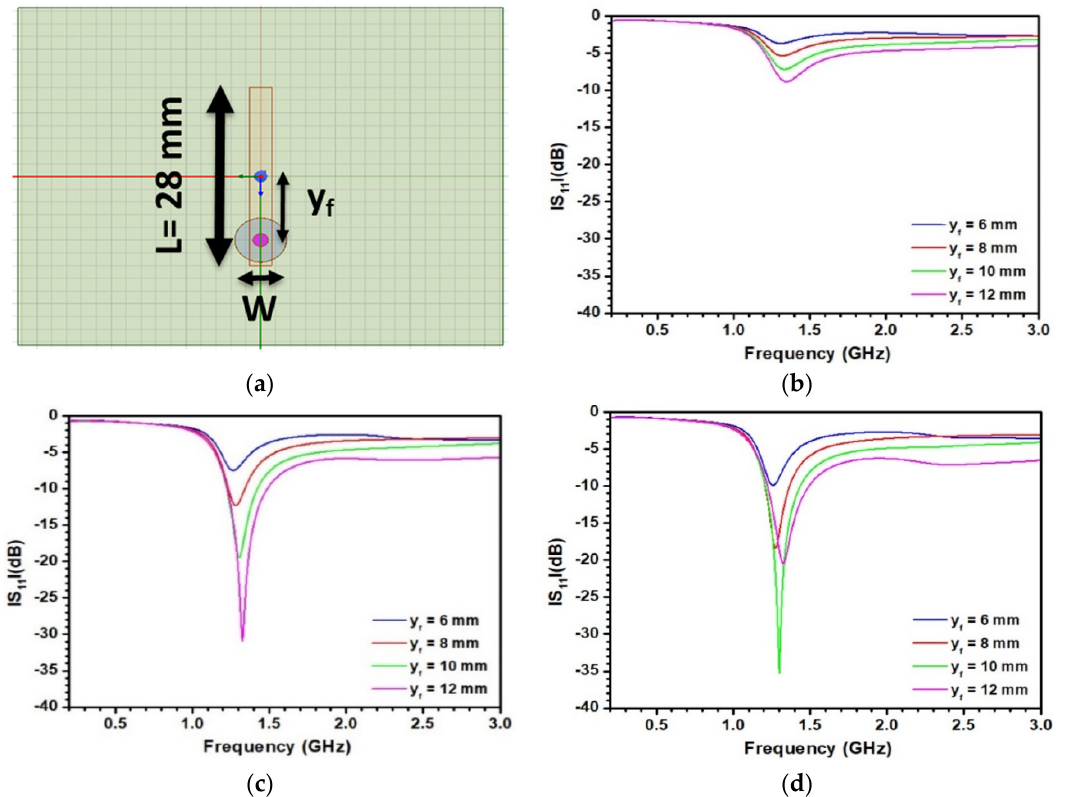
Figure 4. ( a ) Sketch of the antenna and parametric study of the antenna embedded in a material associated with ε (cid:48) = 35, tan δ = 0.1 and operating around 1.3 GHz; ( b ) W = 8 mm, ( c ) W = 4 mm, ( d ) W = 3 mm.